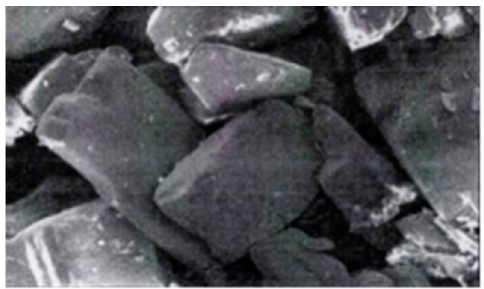
Figure 6. Photograph of secondary electronic image of the Palanenmarble [27].